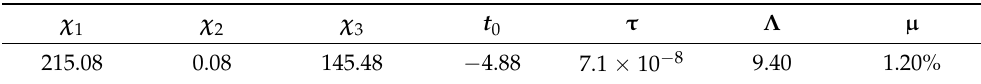
Table 4. Estimation of the parameters χ 1 , χ 2 , χ 3 , t 0 and τ for Qatar using the cumulative reported cases. Λ is per 1000